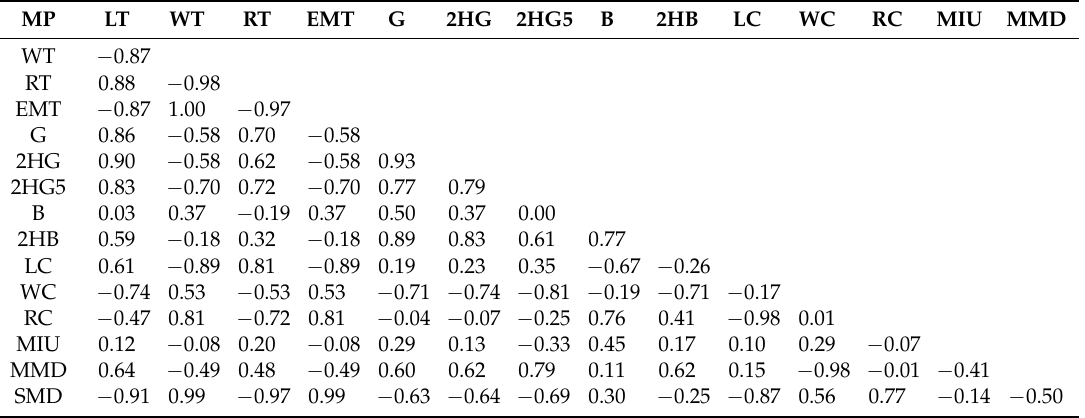
Table 3. The computed Pearson correlation coefficients between the mechanical